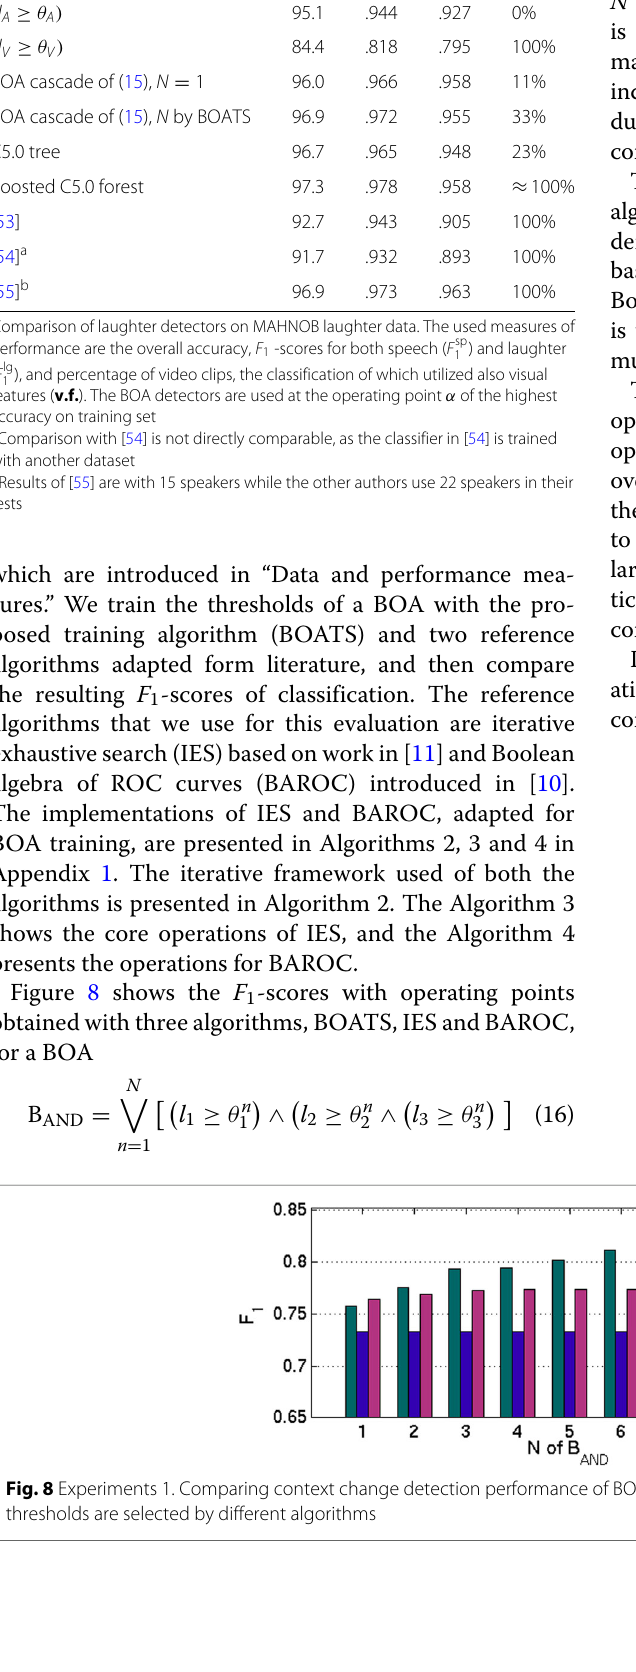
Table 1 Results in laughter detection task